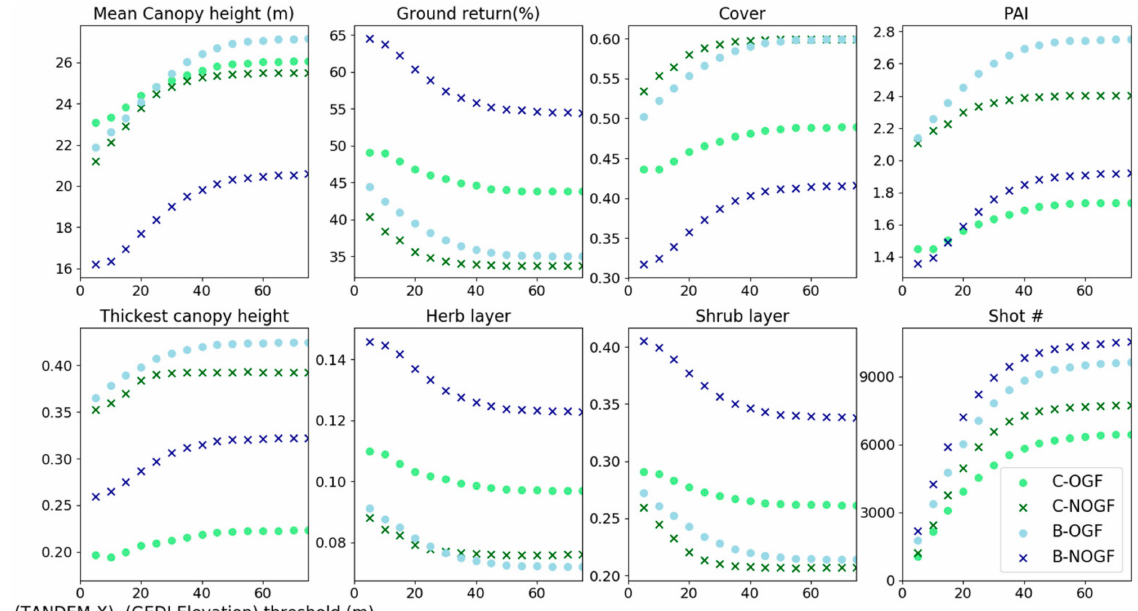
Figure 4. Plots showing the impact on selected structural metrics of removing from the study all GEDI shots with an absolute difference between the TanDEM-X elevation value and the elevation value given by GEDI above the given value, shown on the x -axis for all plots. Markers are either circles (OGF) or crosses (NOGF). Blue markers indicate broadleaf (B), and green markers are conifer (C). Bottom right-hand graph shows the number of eligible shots on the y